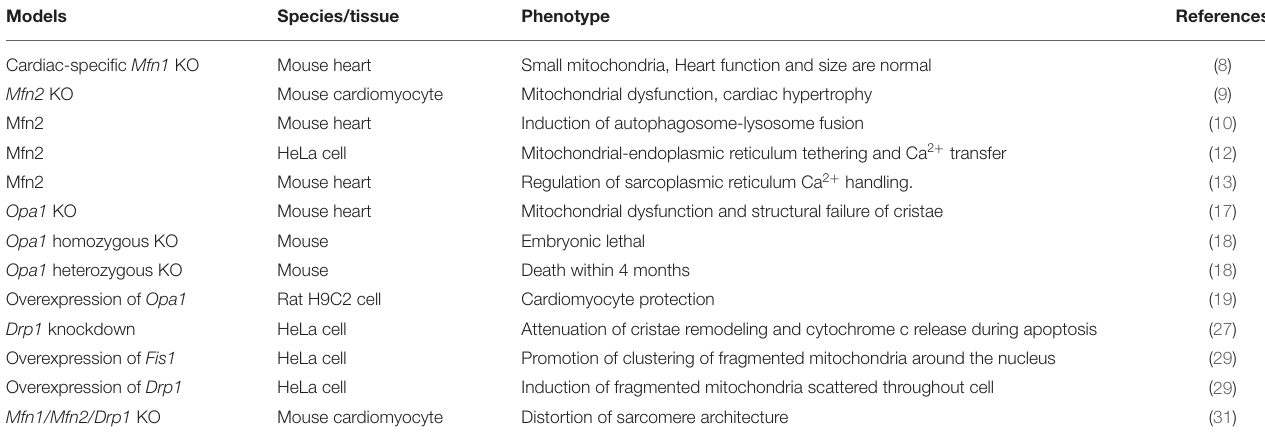
TABLE 1 | Role of mitochondrial